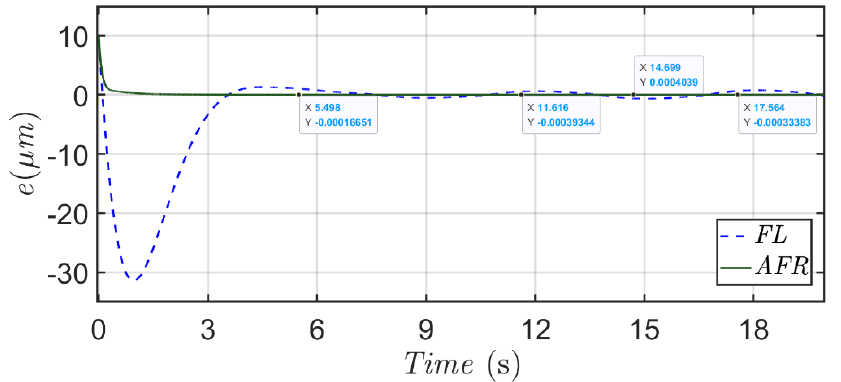
Figure 10. Histories of positioning errors for the proposed method (green line) and feedback linear- ization method (blue dash line) with respect to a desired sinusoidal trajectory .